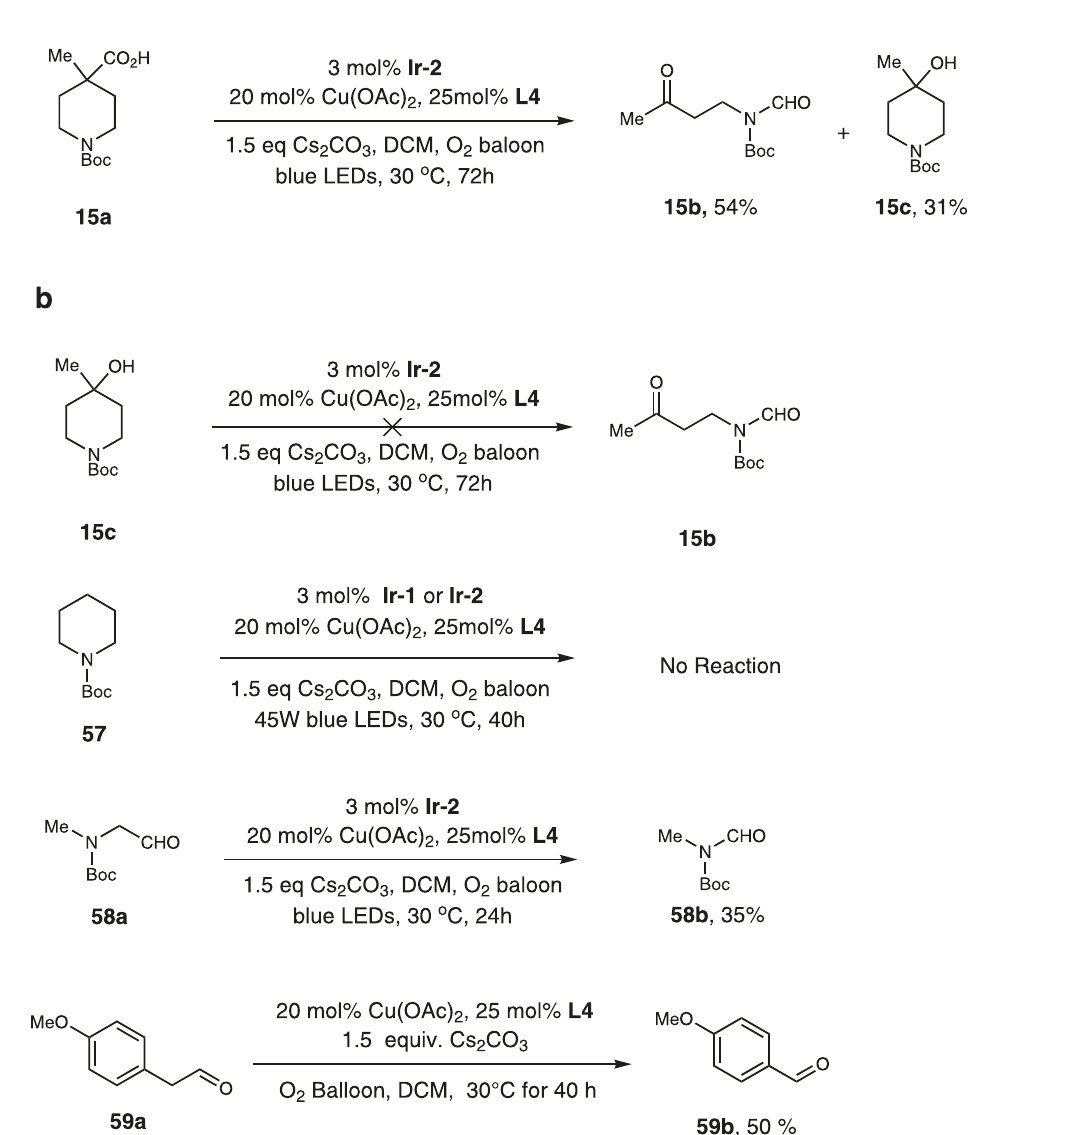
Fig. 8 | Experimental observations for mechanism studies. a The model reaction and the main by-product. b Control